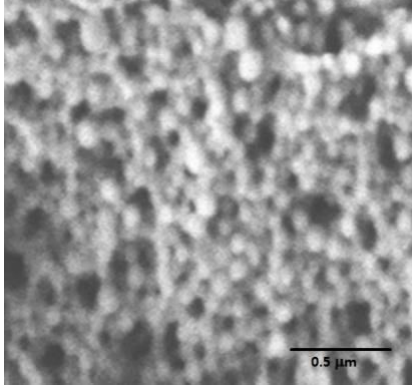
Figure 1. SEM image of the LVS-ZN nanoparticles